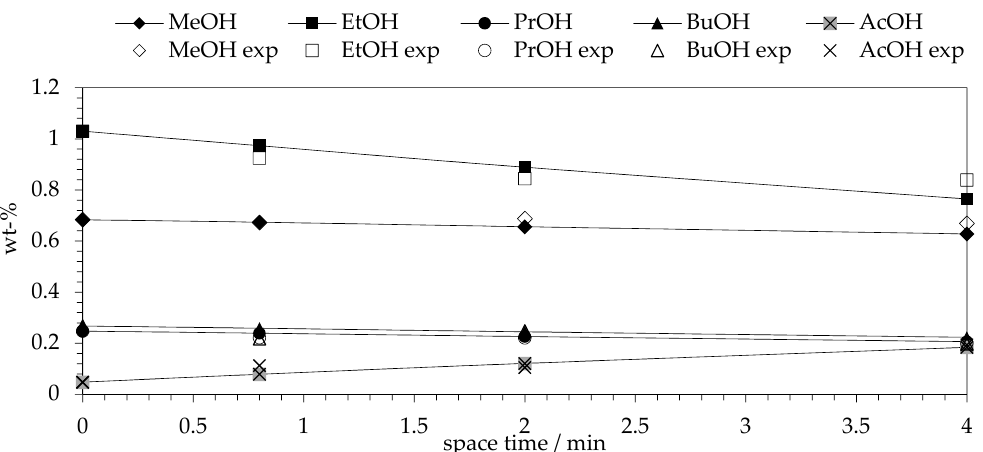
Figure 4. Experimental (empty symbols) and calculated (connected full symbols) weight concentrations of MeOH (diamond), EtOH (cube), PrOH (sphere), BuOH (triangle) and AcOH (cross) at 230 °C, 3.2 MPa and different reactor space-times.